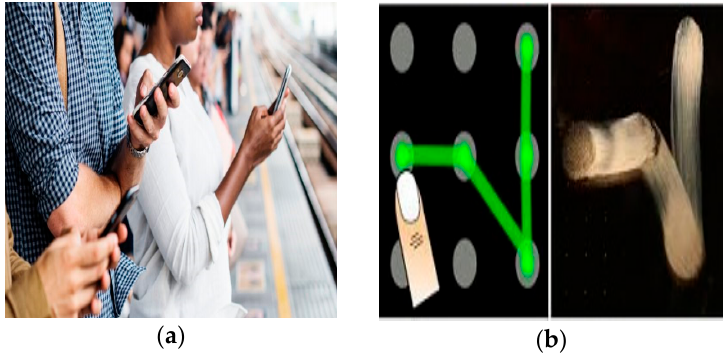
Figure 1. ( a ) Shoulder surfing attack; ( b ) smudge attack.